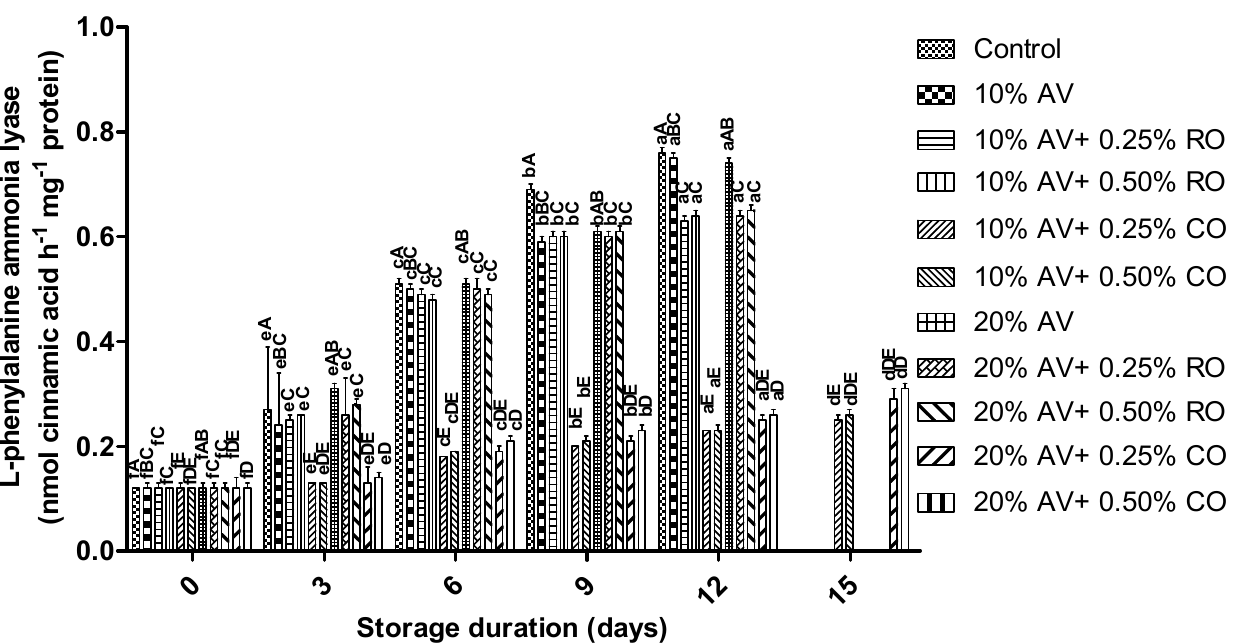
Figure 6. L-phenylalanine ammonia lyase (nmol cinnamic acid h − 1 mg − 1 protein) of ‘Bhagwa’ pomegranate arils that were coated with Aloe vera (AV) gel coatings that were enriched with rosehip oil (RO) (0.25% or 0.50%) and cinnamon oil (CO) (0.25% or 0.50%) and stored at 5 ± 1 °C (95 ± 2% RH) for 15 days. The vertical bars represent the standard deviation (SD) of the mean values of three replicates (1 punnet = 1 replicate, n = 3). Values bearing at least one common small superscript (a, b, . . . , etc.) and at least one common capital superscript (A, B, . . . , etc.) letters differ significantly between the days and between the coating solution/concentrations, respectively, at p < 0.05 in Duncan’s multiple comparison post hoc